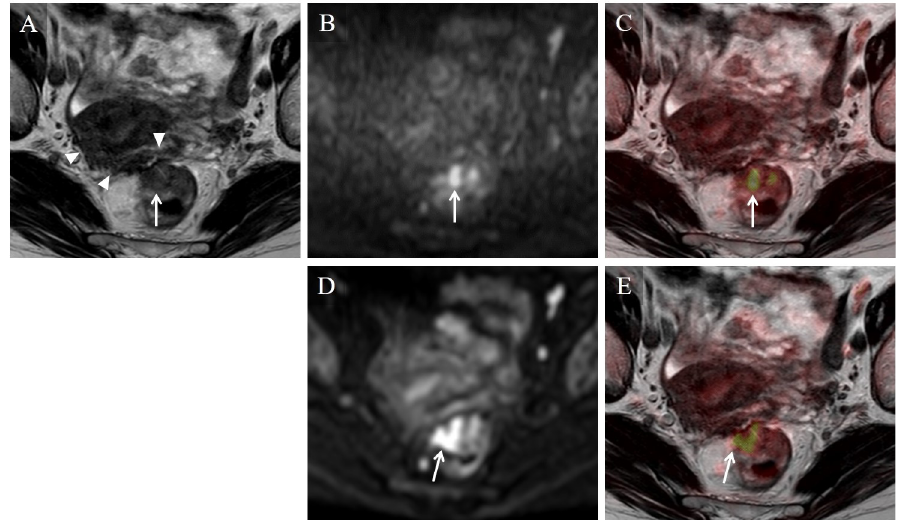
Fig 3. Stage T2 rectal carcinoma in a 75-year-old woman. On the T2WI image (A), a low intensity area extended from the mesorectal fascia into the surface of the uterus (arrow-head). Five readers misdiagnosed the stage as T4a or T4b with T2WI alone. This area did not show high intensity on the DWI image, and was considered as fibrosis. A high intensity lesion was seen on TSE-DWI (B) and EPI-DWI (D) image (arrow). On the fusion image of TSE-DWI (C), 7 readers accurately diagnosed the stage as T2. On the fusion image of EPI-DWI (E), an area of diffusion restriction was shown beyond the muscularis propria (arrow) probably due to image distortion, and the stage was misdiagnosed as T3.